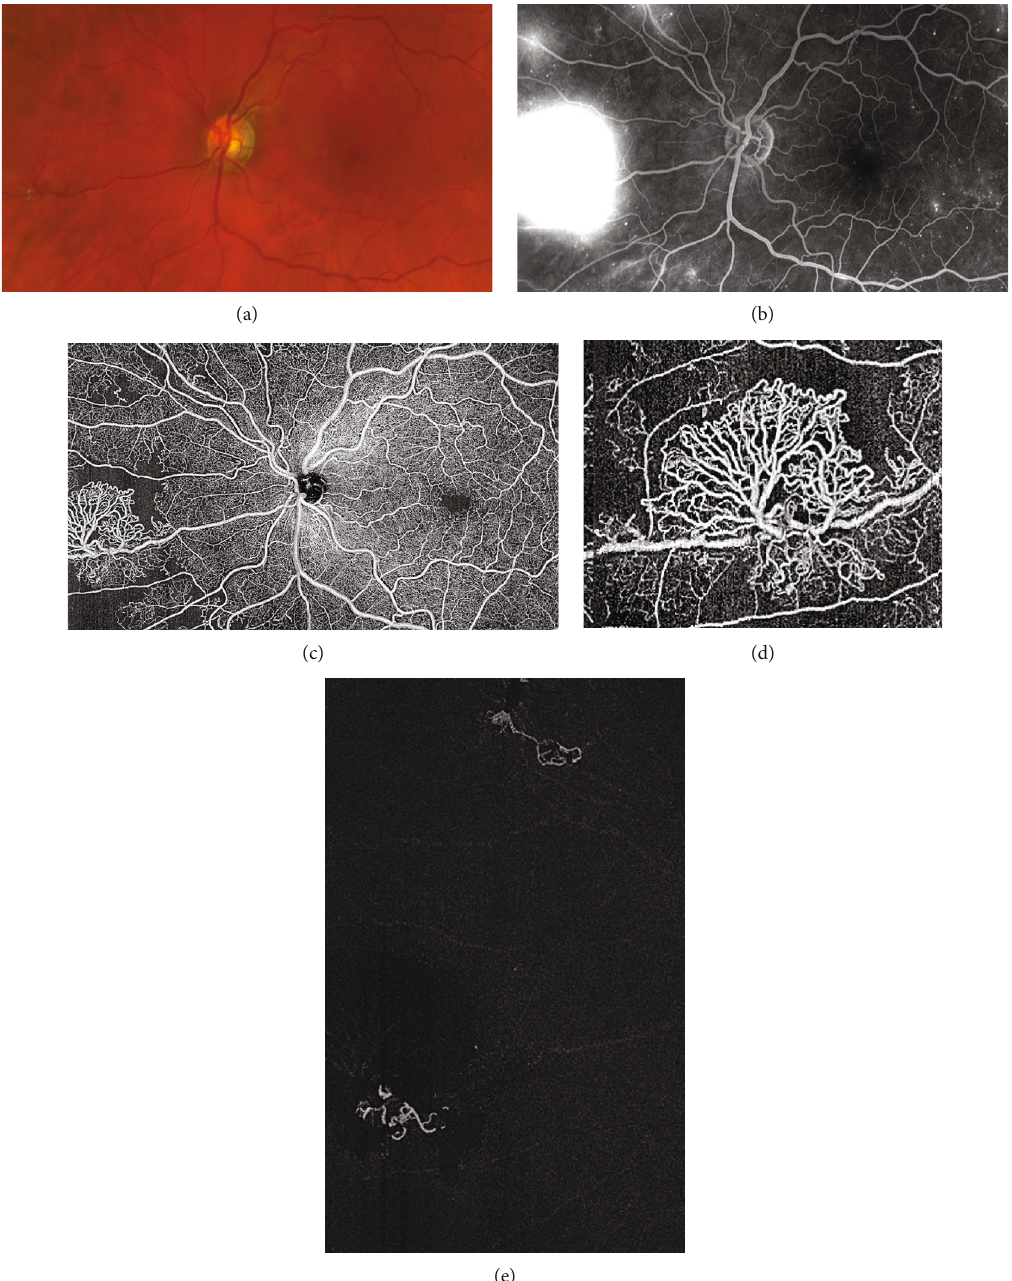
Figure 4: Proliferative diabetic retinopathy with neovascularization elsewhere. (a) Color fundus picture showing the neovascular epiretinal network in the nasal periphery. (b) Fundus fl uorescein angiography (FFA) shows marked hyper fl uorescence due to dye leakage in the late phase of the exam. Morphologic characterization of the neovascularization is not possible using FFA. (c) Wide fi eld optical coherence tomography angiography of the same eye, depicting the neovascularization (NV) and its peripheral loops (d). (e) Vitreoretinal slab of OCTA, showing the NV protruding into the